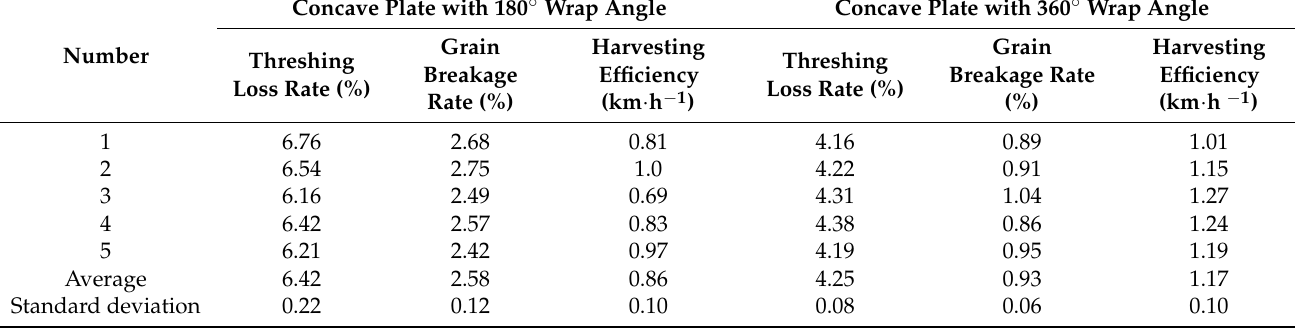
Table 12. Field test